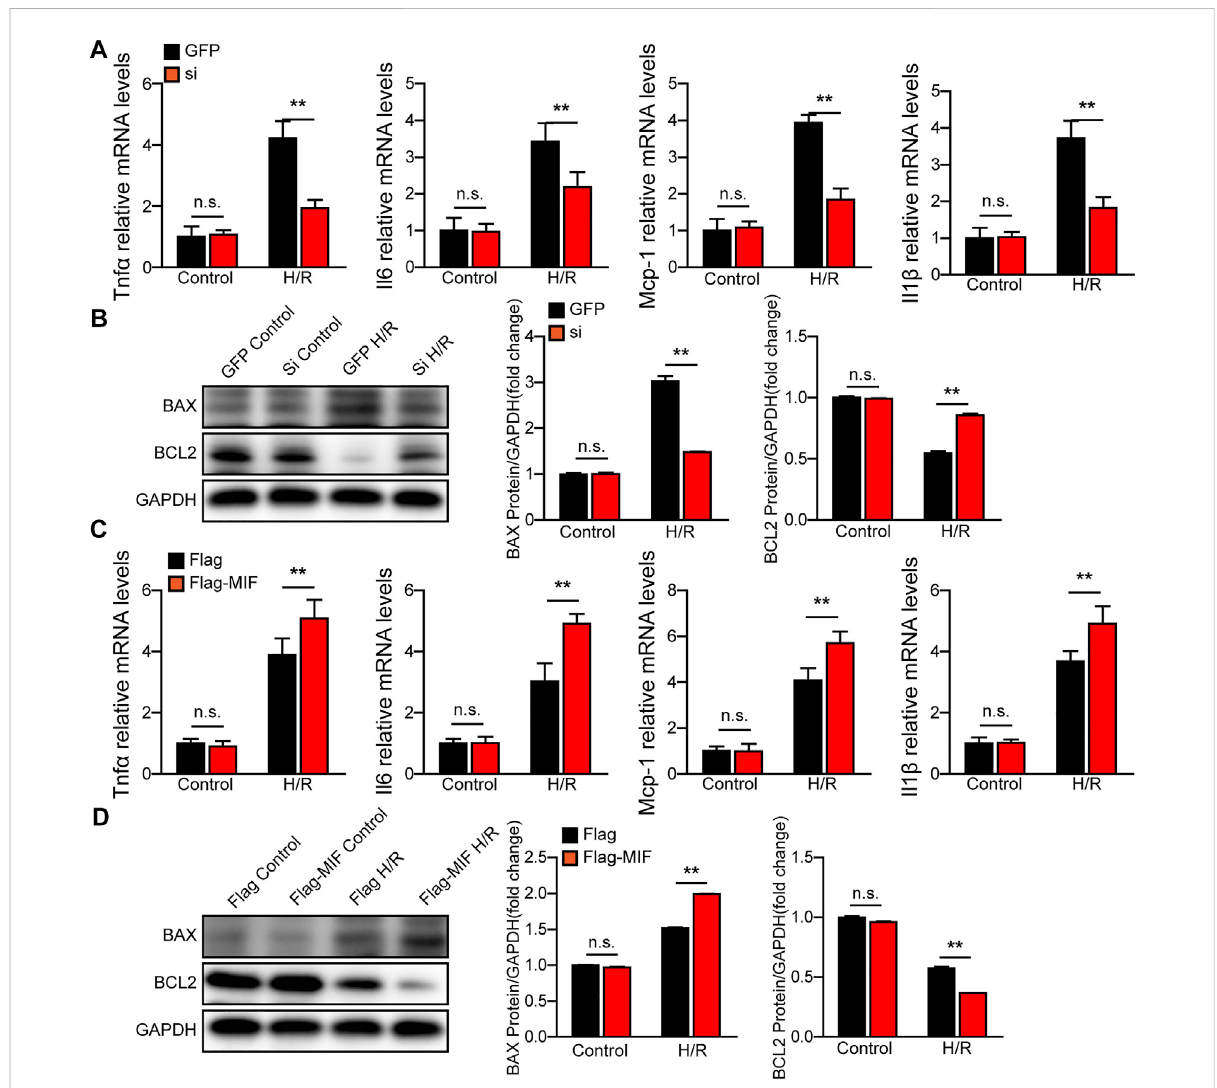
FIGURE 6 MIF knock-down protects hepatocytes from H/R injury. (A) The mRNA levels of proin fl ammatory factors ( Tnf α , Il6 , IL1 β , and Mcp-1 ) in cultured MIF knockdown hepatocytes challenged by H/R treatment. Representative of three independent experiments. (B) Western blot analysis of the protein expression levels of Caspase3, Bax, and Bcl2 in cultured MIF knockdown hepatocytes challenged by H/R treatment. GAPDH served as the loading control. Representative of three independent experiments. (C) The mRNA levels of proin fl ammatory factors ( Tnf α , Il6 , IL1 β , and Mcp-1 ) in cultured MIF overexpressed hepatocytes challenged by H/R treatment. Representative of three independent experiments. (D) Western blot analysisoftheproteinexpressionlevelsofCaspase3,Bax,andBcl2inculturedMIFoverexpressedhepatocyteschallengedbyH/Rtreatment.GAPDH servedastheloadingcontrol.Representativeofthreeindependentexperiments.Alldataareshownasthemean±SD.Levelsofstatisticalsigni fi cance areindicatedas** p < 0.01.Forstatistical analysis,one-way ANOVAwithBonferroni ’ sposthocanalysisorTamhane ’ sT2posthocanalysis